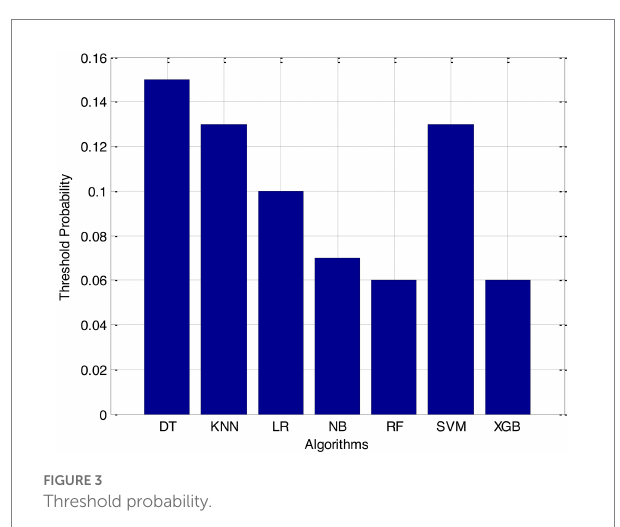
FIGURE 3 Threshold probability.